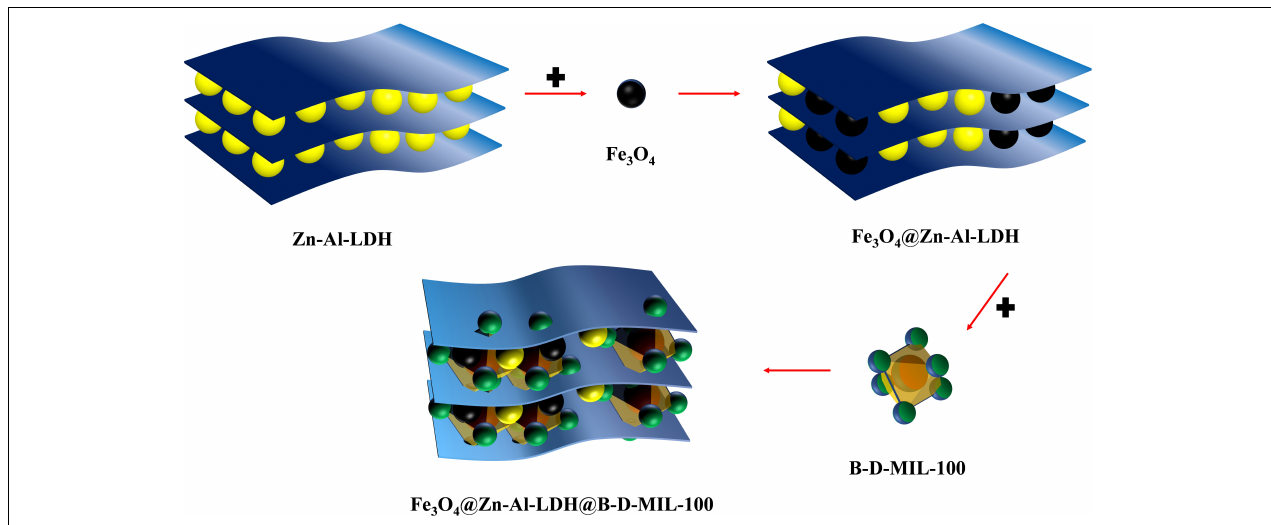
FIGURE 1 | Process for the synthesis of composite